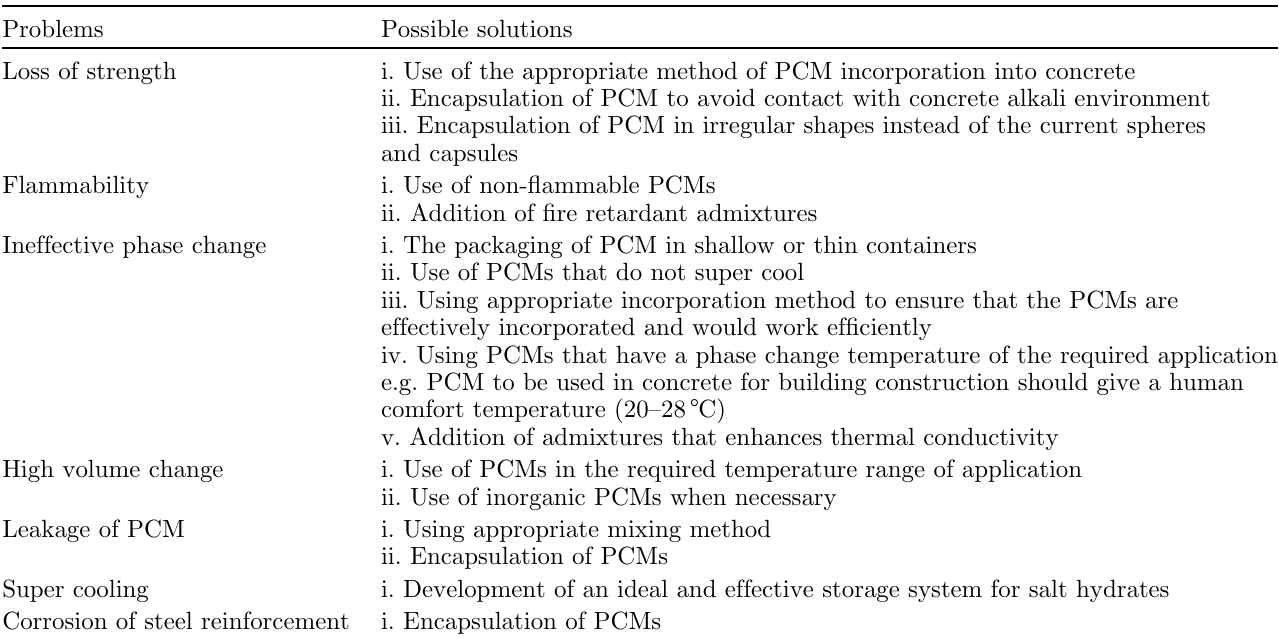
Table 3. Possible solutions to current challenges faced by the use of PCM in concrete.